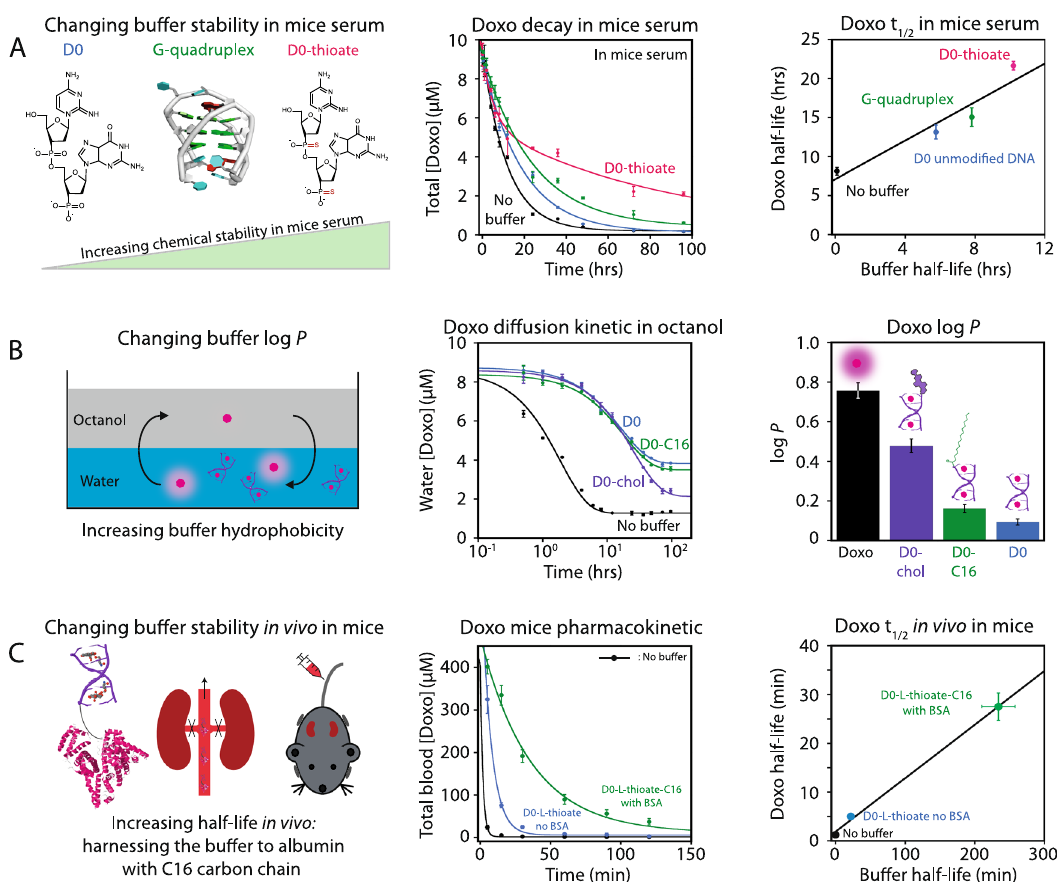
Fig. 5 | Optimizing the pharmacological properties of doxorubicin through chemical modi fi cations of its buffer. A Increasing the chemical stability of dox- orubicin in mouse serum by increasing its buffer chemical stability (left panel) resultedinincreasingthedoxorubicinhalf-life(middleandrightpanels).Blackline: no buffer; blue line: D0 buffer; green line: G-quad buffer; pink line: D0-thioate buffer. Total doxorubicin concentrations were determined using HPLC- fl uorescence measurements, while DNA buffer half-lives were determined using SYBR green fl uorescence (supplementary Fig. 12). Data in the middle panel were fi tted with equation E19 — see Supplementary Information) and a linear regression was used for the right panel. For each condition, n =3 independent experiments. Data were presented as mean values±SD. B Programming the doxorubicin parti- tion coef fi cient log P (left panel) by modifying the hydrophobicity of the buffer resulted in different water-to-octanol diffusion (middle panel), which changed the